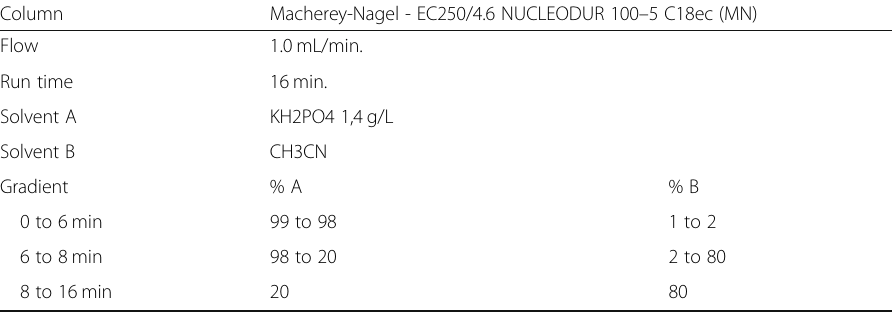
Table 3 The final HPLC conditions proposed